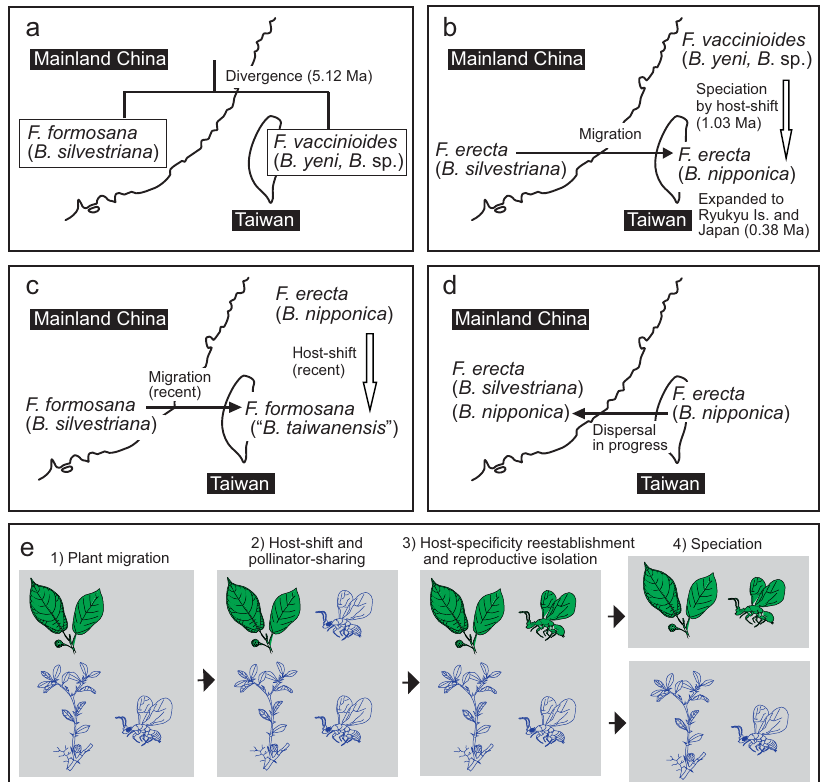
Fig. 6 Establishment of the mutualistic relationships in the F. erecta complex and its pollinators (in parentheses) in the Taiwan-Ryukyu islands (a – d) and a model for host-shift speciation proposed in this study (e). a The divergence of F. vaccinioides – B. yeni / B . sp. and F. formosana – B. silvestriana . b F. erecta migrated into Taiwan from mainland China. Blastophaga sp. host-shifted to F. erecta and speciated into B. nipponica . Then, the distribution range of F. erecta – B. nipponica expanded northward to the Ryukyu Islands and Japan. The chronology in a and b is based on the dating analysis of the pollinators (Supplementary Fig. 10). c F. formosana probably migrated into Taiwan recently from mainland China, and B. nipponica host-shifted to F. formosana ; at present, F. erecta and F. formosana appear to share B. nipponica including “ B. taiwanensis ” in Taiwan. d B. nipponica dispersed from Taiwan to the Fujian region (FJ) of mainland China, resulting in an example of sympatric co-pollination. e The proposed model for the host-shift speciation events described in this study consists of four stages: (1) Host fi gs migrate into a new niche without their original pollinators; (2) The migrated host fi gs are pollinated by new wasps (host shifting); as a result, two host fi g species share one wasp pollinator (pollinator sharing); (3) The host-shifted wasps evolve and become associated with the host fi gs that migrated (host-speci fi city reestablishment), and reproductive isolation occurs; (4) Genetic divergence proceeds and speciation occurs. These images show only the evolutionary events, not the details of the evolution of fi gs and pollinators during these